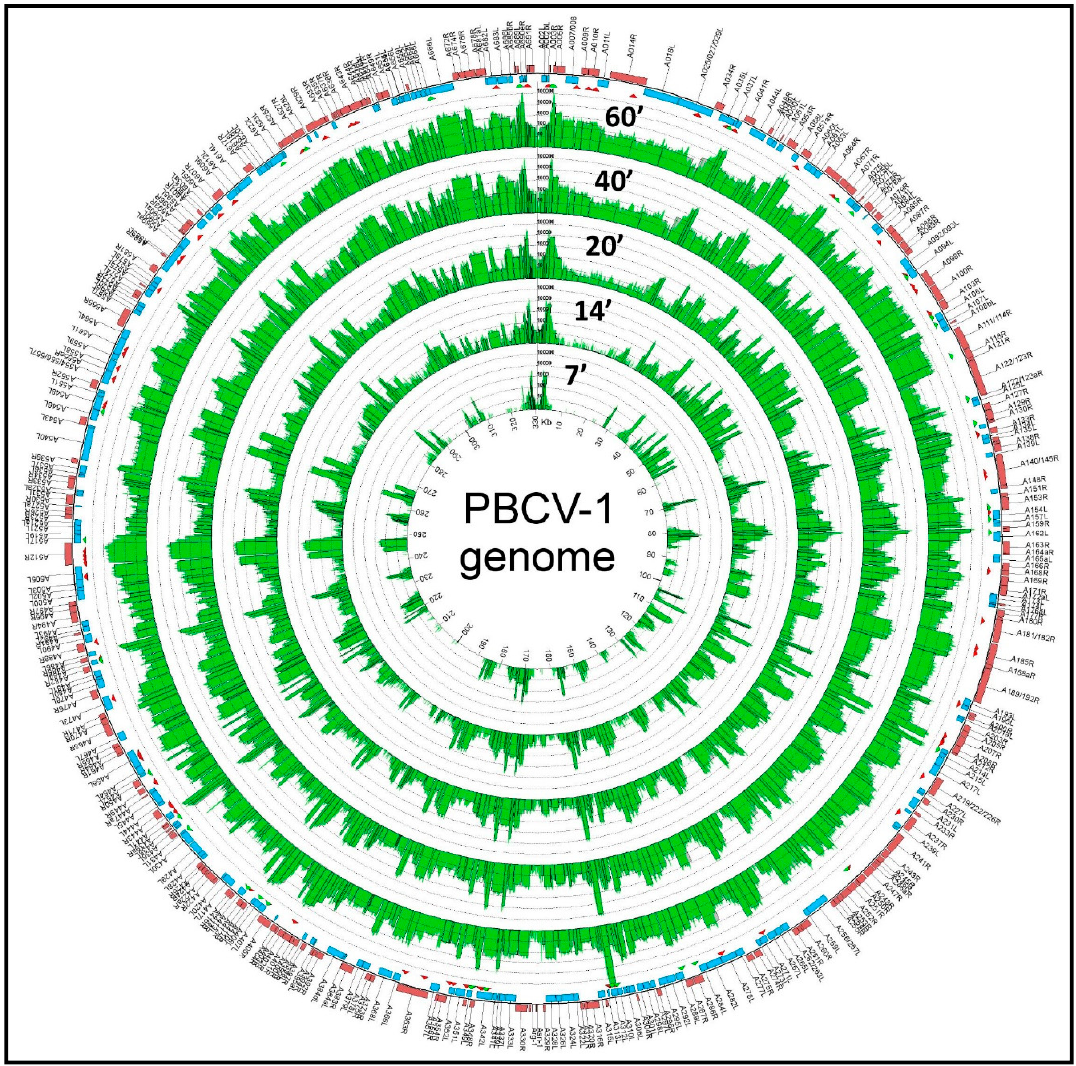
Figure 5. Mapping of the PBCV-1 transcriptome at various times post infection. PBCV-1 genes on the forward and reverse strands are depicted by red and blue boxes, respectively. The green curves in the interior concentric circles represent the normalized read coverage for each time point (7, 14, 20, 40, and 60 min p.i.) of the experiment in logarithmic scale (base 10). Note: the PBCV-1 genome is a linear molecule with inverted repeats and closed hairpin ends that is depicted as a circle. The two ends are at the 12 o’clock position. The figure is from Blanc et al. [75] and published with permission.